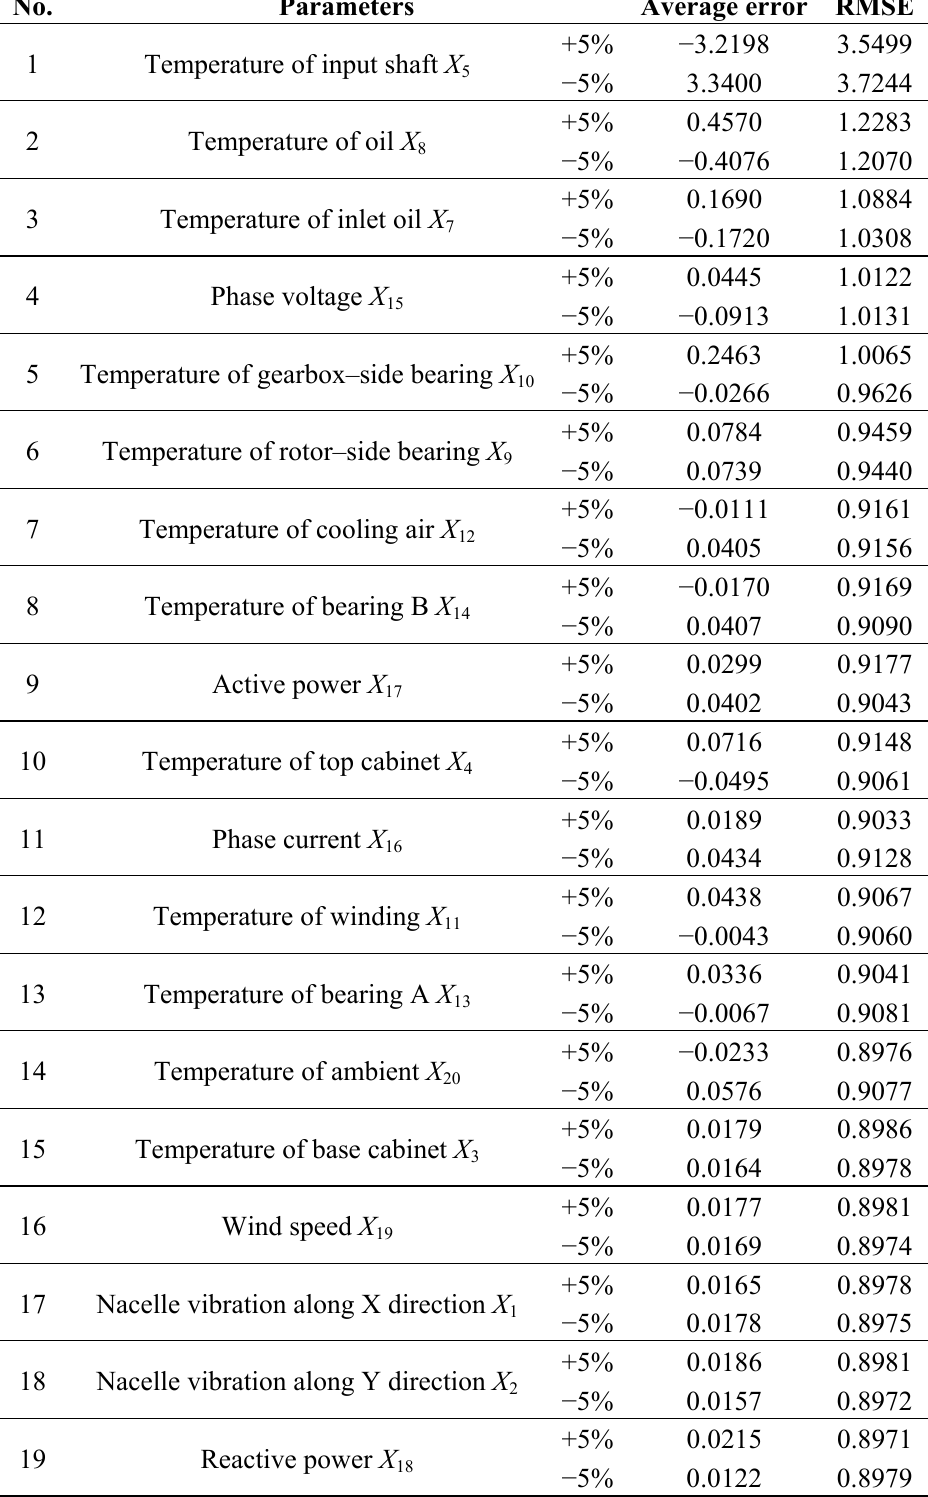
Table 4. Influence of the parameters on output shaft temperature of